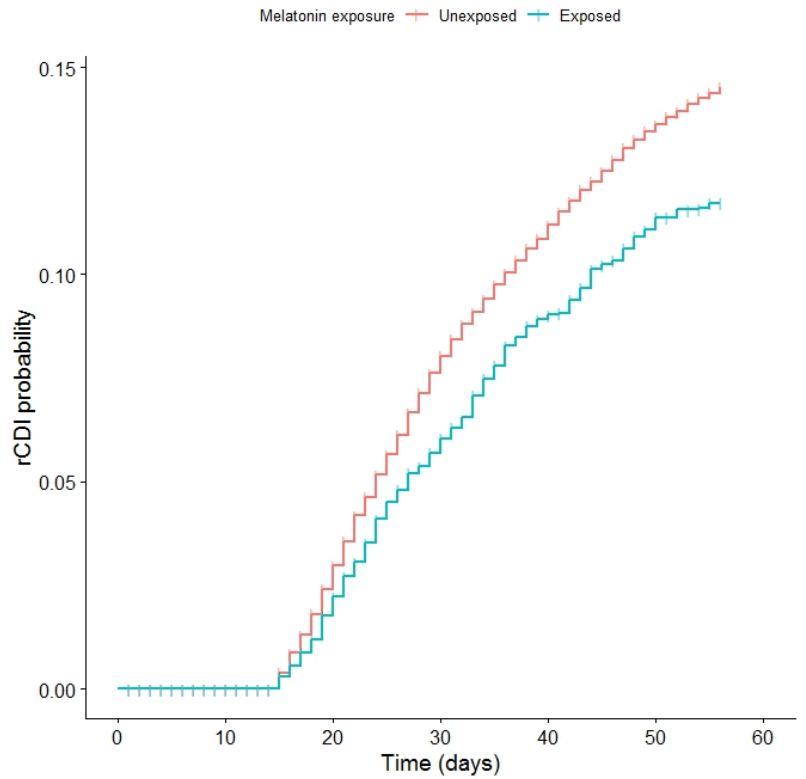
Figure 1 . Kaplan–Meier curve of the two cohorts, univariate results. A p value < 0.001 demonstrates a statistically significant difference in recurrent CDI for the melatonin-exposed cohort compared to the unexposed cohort.